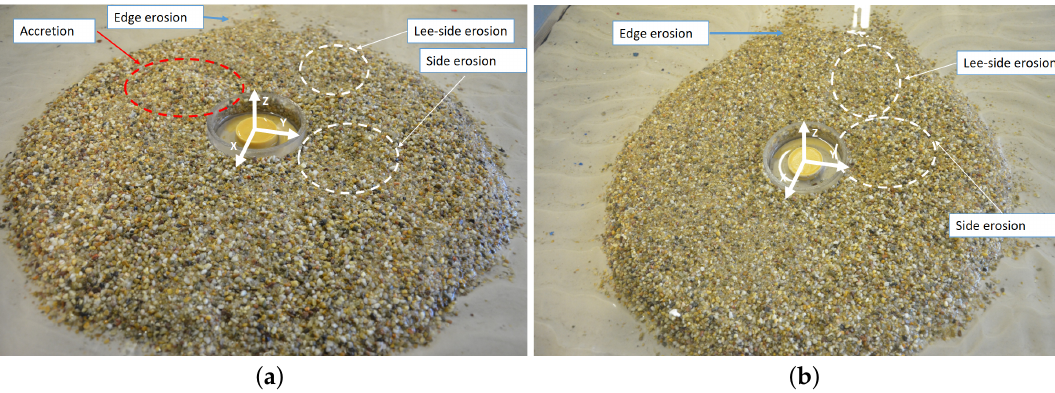
Figure 13. Photo visualisation of erosion and accretion areas in the end profiles: ( a ) TG1_4 end state; ( b ) TG2_4 end state. Table 8. Damage numbers of the scour protection armour layer and associated subarea of where the maximum erosion is